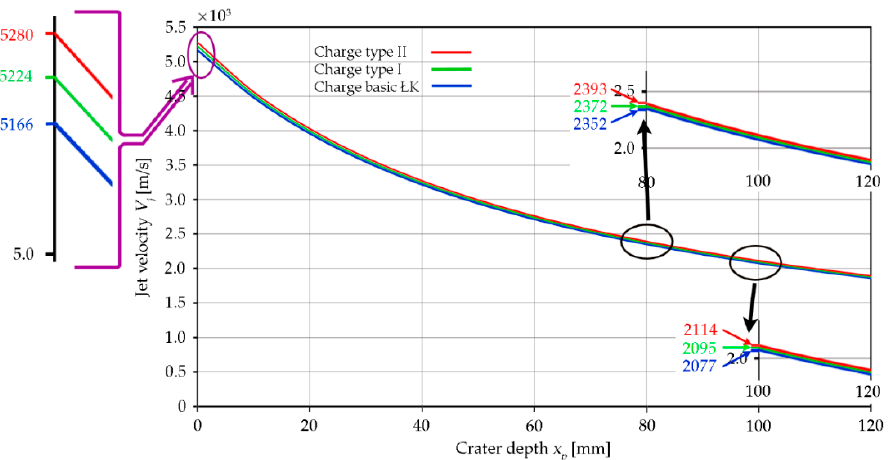
Figure 15. Dependence of the jet velocity on the armor plate penetration depth.